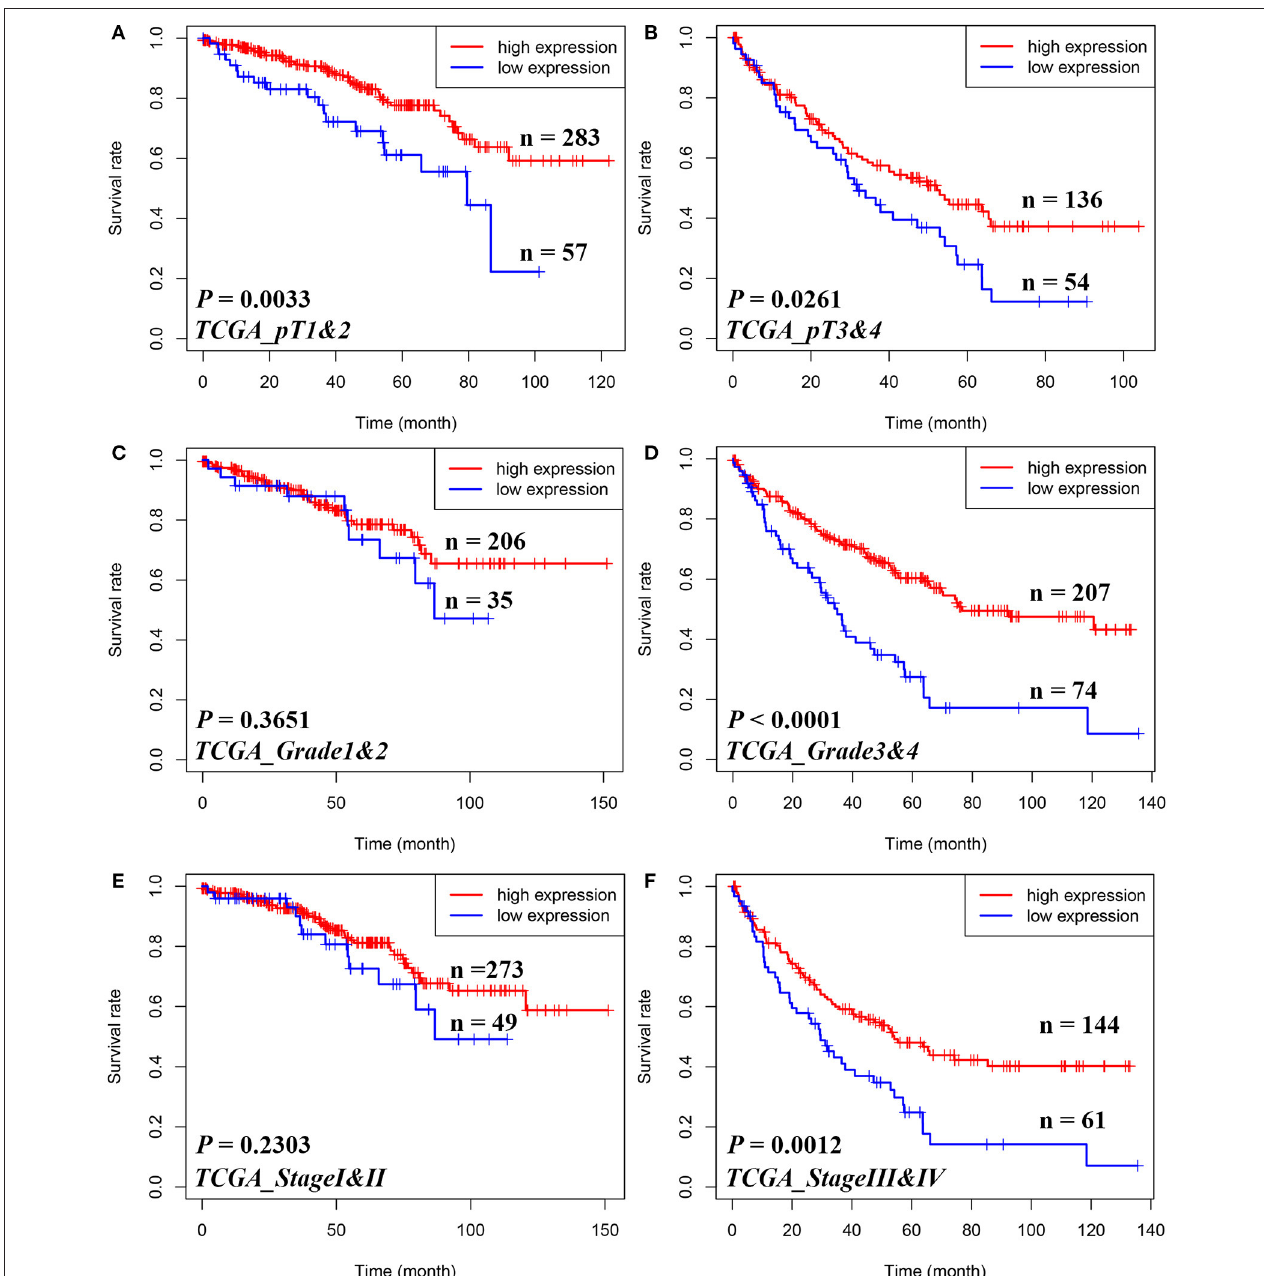
FIGURE 2 | Subgroup analyses to assess the prognostic value of STAM1 based on pT stages, tumor grades, and American Joint Committee on Cancer (AJCC) stages in clear cell renal cell carcinoma patients from The Cancer Genome Atlas. Kaplan–Meier analyses of overall survival in patients with pT1 and 2 (A) , pT3 and 4 (B) , grade 1 and 2 (C) , grade 3 and 4 (D) , AJCC stage I and II (E) , and AJCC stage III and IV (F) .